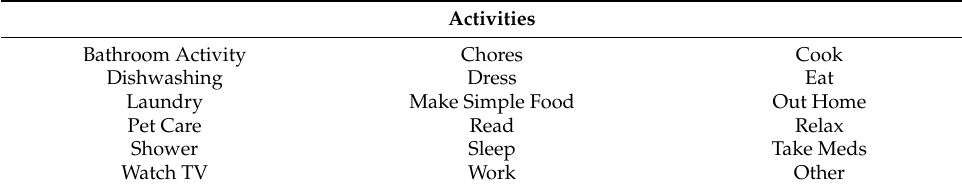
Table 2. Set of activities labelled in the database.